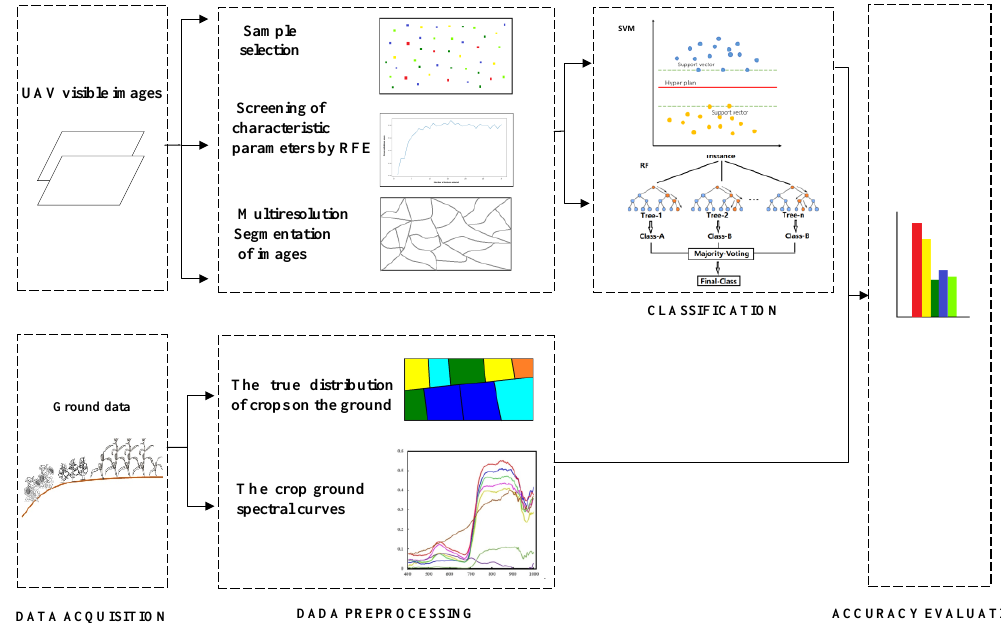
Figure 5. Workflow of planting structure